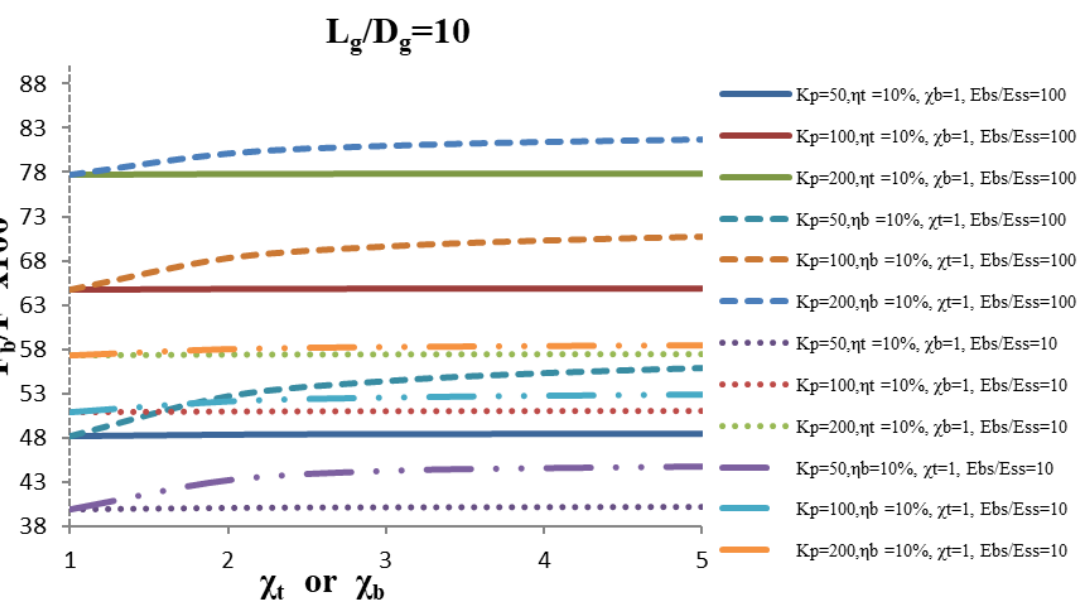
, or strengthening factor for the bottom, χ t /E , on a single partially strengthened GP (L bs ss